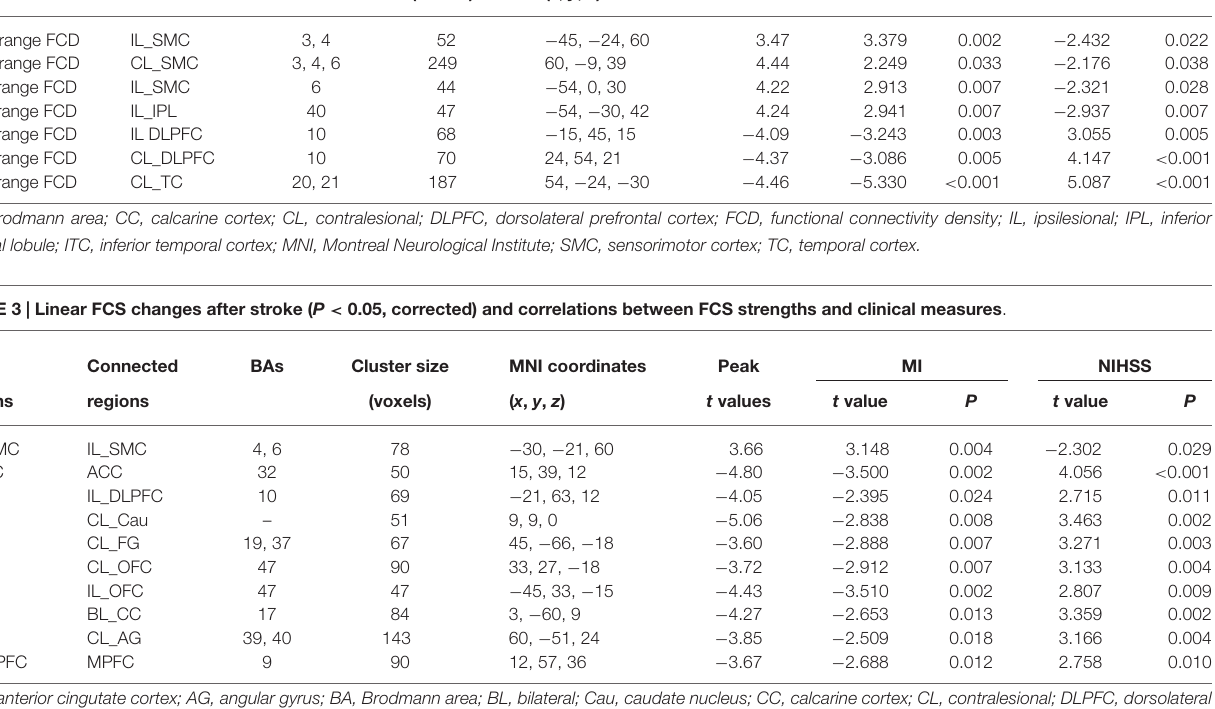
Short-range FCD